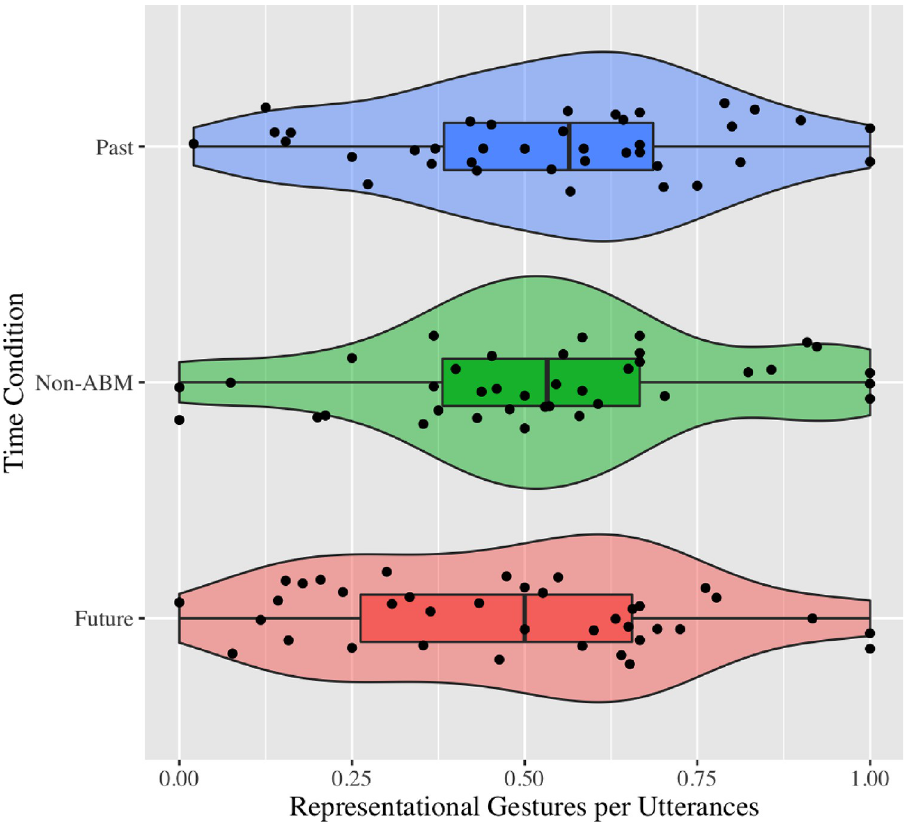
Fig 1. Scatterplots illustrating relations between event conditions and representational gesture rate. Note . None- ABM corresponds to non-autobiographical memories.